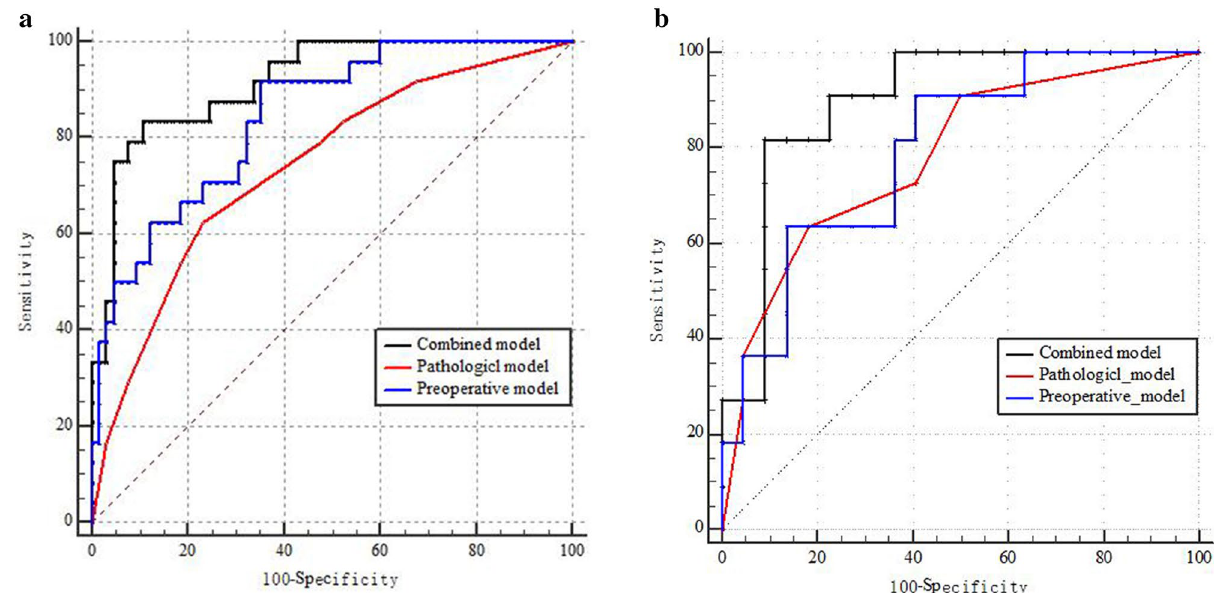
Figure 2. Kaplan–Meier survival curves of IMCC patients with and without early recurrence in the training set ( a ) and test set ( b